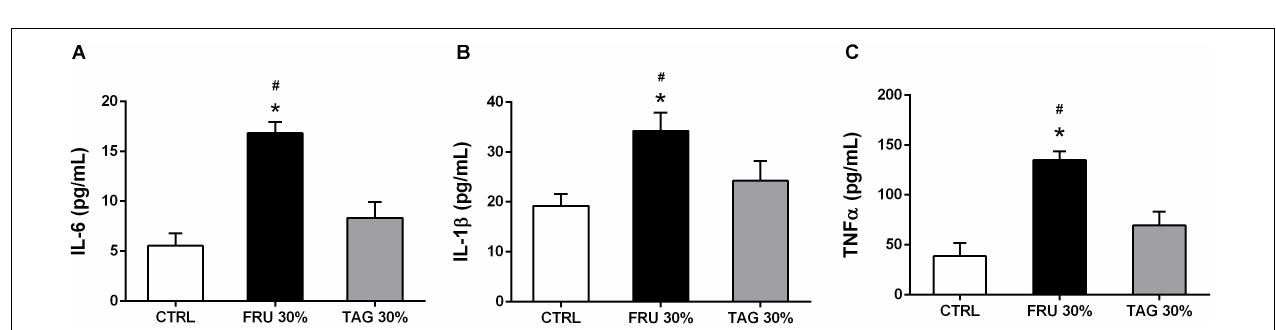
FIGURE 5 | Impact of fructose- or D -tagatose-rich diets on oxidative stress markers. (A) 8-hydroxy-2 (cid:48) -deoxyguanosine (8-OH d G) and (B) malonyldialdehyde (MDA), were measured in heart of rats fed with CTRL, FRU 30% or TAG 30%. Values are represented as means ± SD of 8 (CTRL and TAG 30%) and 7 (FRU 30%) animals per group; * p < 0.05 vs. CTRL; # p < 0.05 vs. TAG 30%.